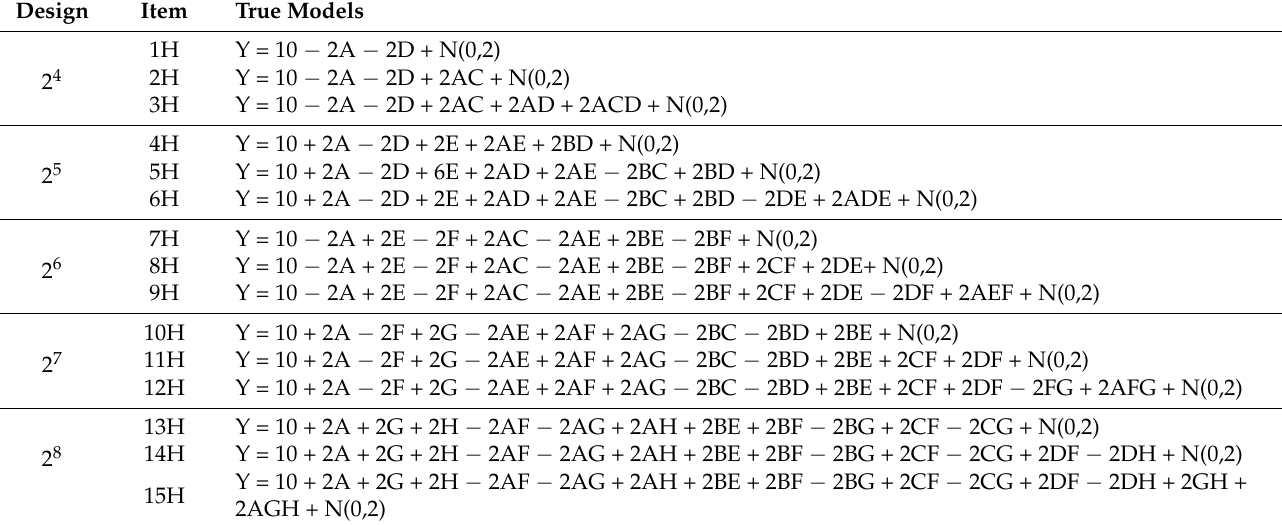
Table 5. True models with high